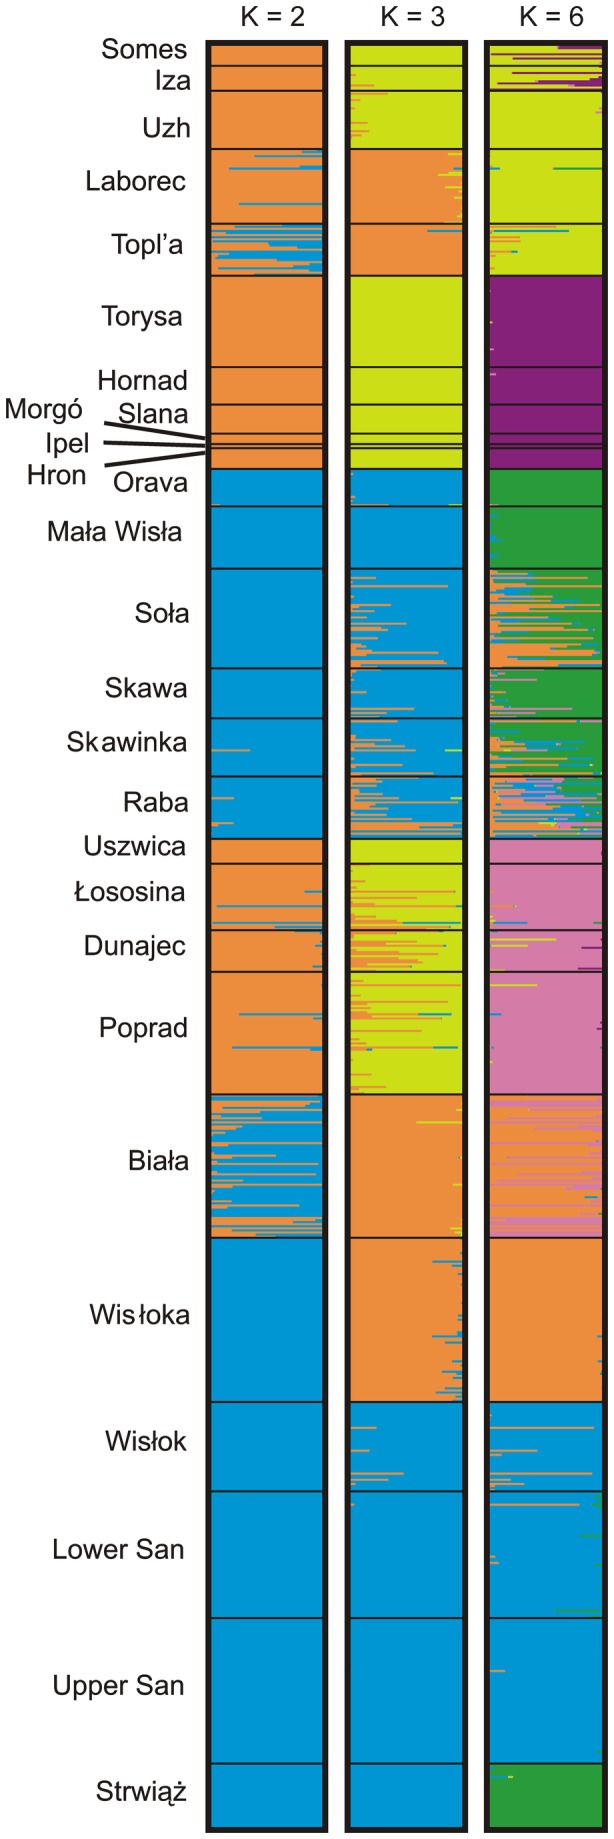
Proportional membership (q) of all individuals genotyped at microsatellite loci, for 3 different number of clusters (K = 2, 3, 6) identified by Structure.